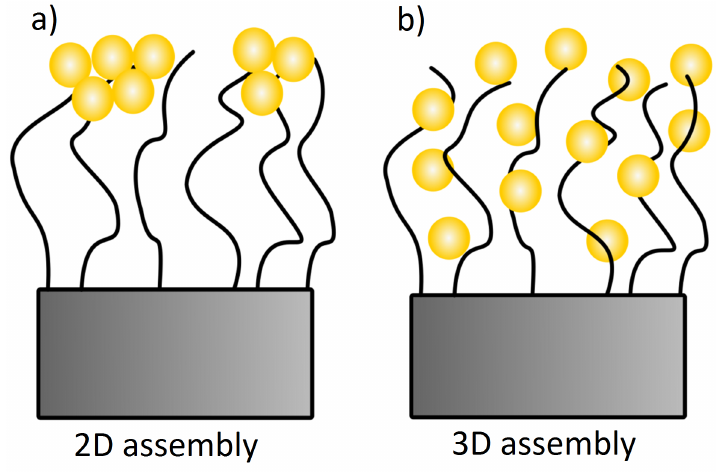
Figure 10. Two suggested assembly of brush/AuNP composites. Here, composites at pH 4 form more likely ( a ) a 2D assembly while composites at pH 8 form mainly ( b ) a 3D